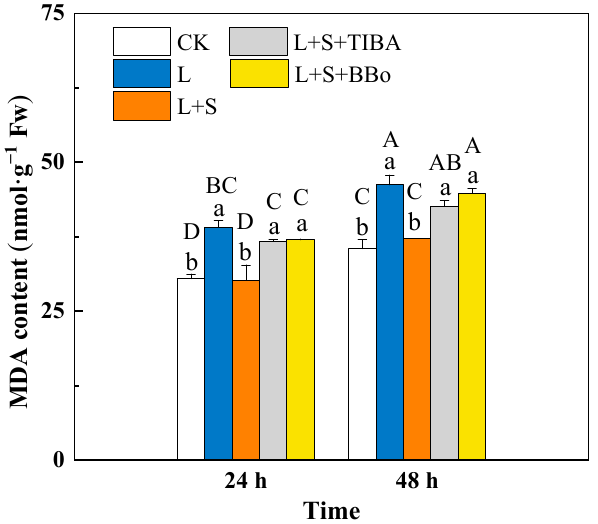
Figure 3. Effects of exogenous sucrose and IAA inhibitors on MDA contents of M. baccata under sub-low temperature. Bars indicate means ± standard error ( n = 3). The lowercase letters represent significant differences between treatments ( p < 0.05). The capital letters represent significant differences between full data ( p < 0.05). The comparison of means is based on the Duncan’s multiple range test. CK, control treatment; L, sub-low root-zone temperature (5 °C); L + S, 5 °C + 90 mmol·L − 1 sucrose; L